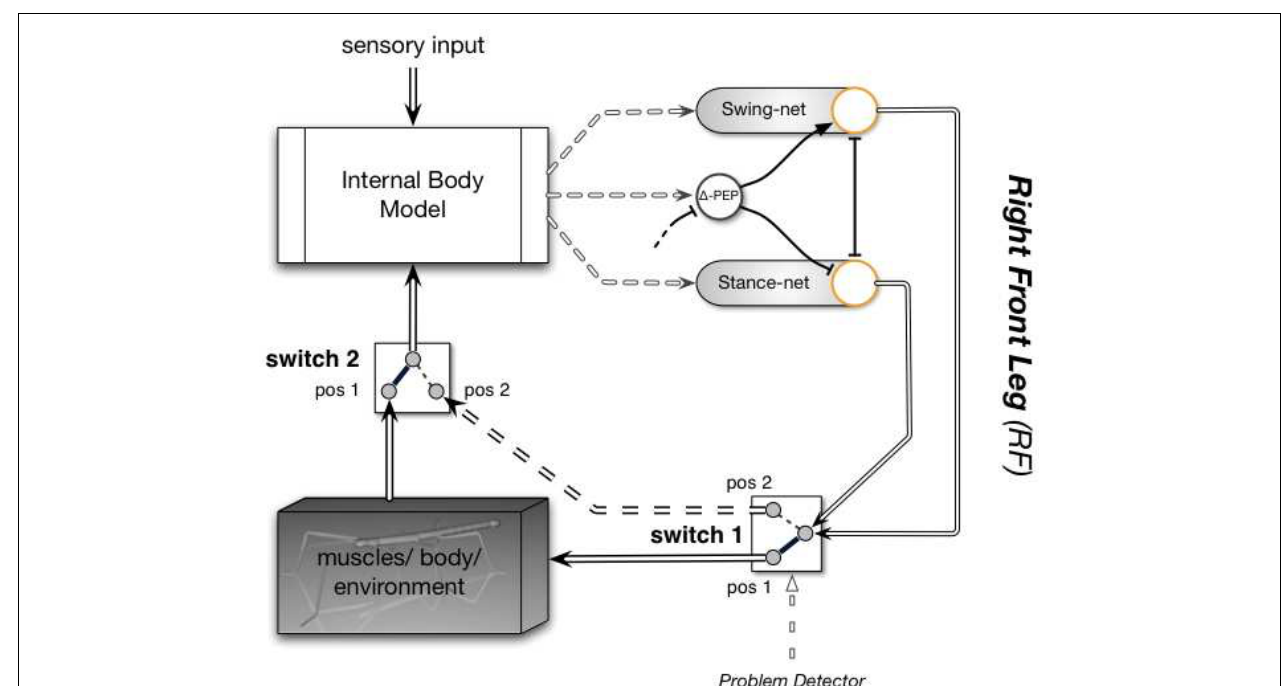
input (e.g., from the antennae or visual input, arrow from above). If the system runs into a problem, the body model is, together with the procedural networks (Swing-net, Stance-net), used for trying out variations of behaviors. In this case both switches are flipped from position 1 to position 2 and the motor control (double-lined arrows entering switch 1 on the right) is routed, not to the body anymore, but to the body model (dashed double line).This circuit is used for internal simulation and predicts the sensory consequences of the action.The whole process is repeated until a suitable behavior has been found. For further explanations see